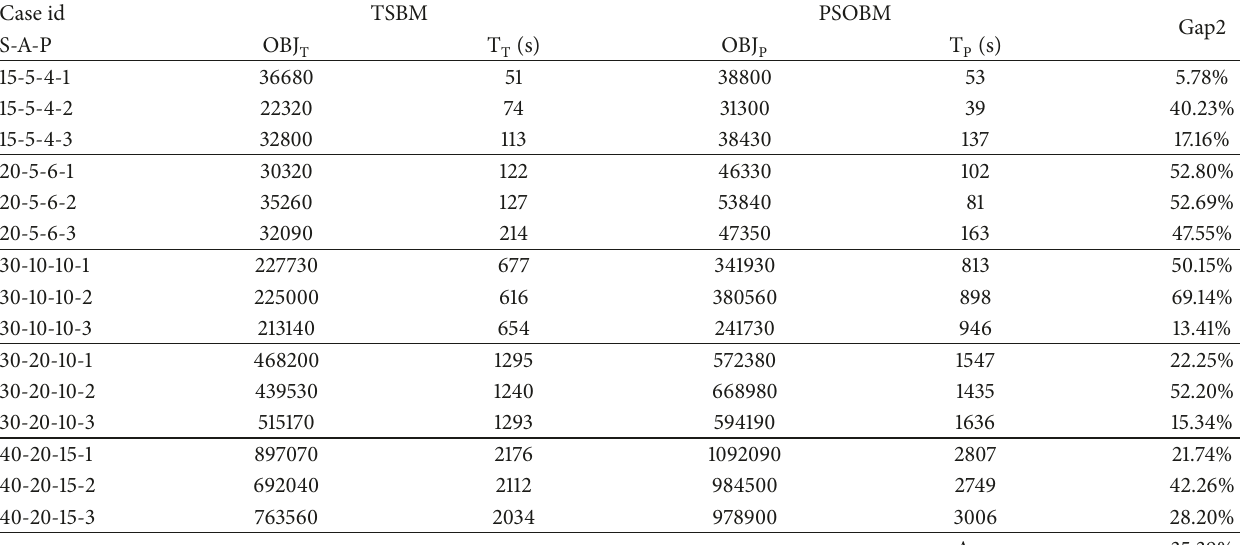
Table 2: Comparison between TSBM and